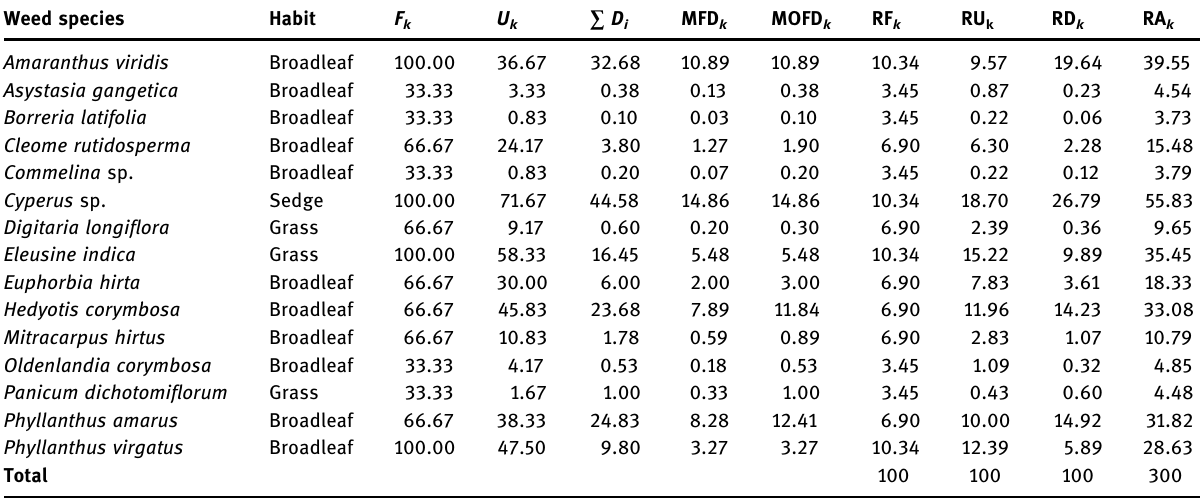
Table 1: Phytosociological parameters of weed species in a corn fi eld in 2017, 2018, and 2020 Weed